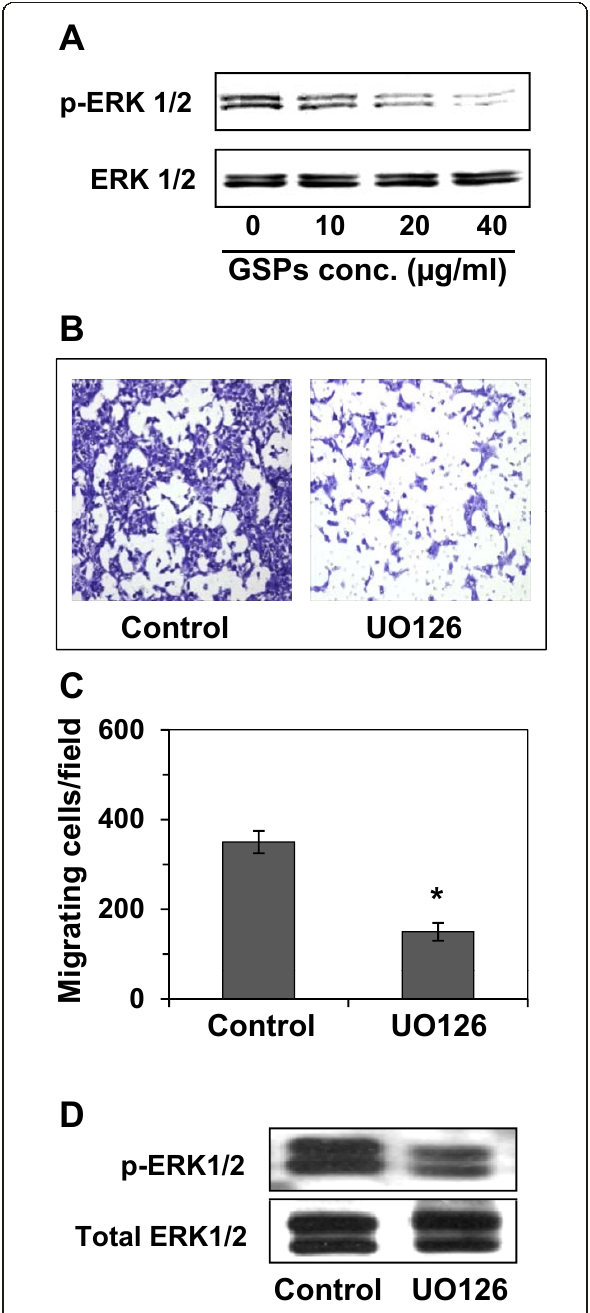
Figure 4 GSPs inhibit SCC13 cell invasion by inhibiting activation of ERK1/2 . (A) GSPs inhibit the activation of ERK1/2 in SCC13 cells dose-dependently. (B) Treatment of SCC13 cells with MEK inhibitor (UO126, 80 μ M) inhibits the invasion of cells compared to non-MEK inhibitor-treated control cells. (C) The data on cell invasion capacity are summarized and expressed as the mean number of invasive cells ± SD/microscopic field, n = 3. Significant difference versus control * P < 0.001. (D) The treatment of cells with MEK inhibitor also inhibits the activation of ERK1/2 in cells as determined by western blot analysis. Representative blot is shown from three separate